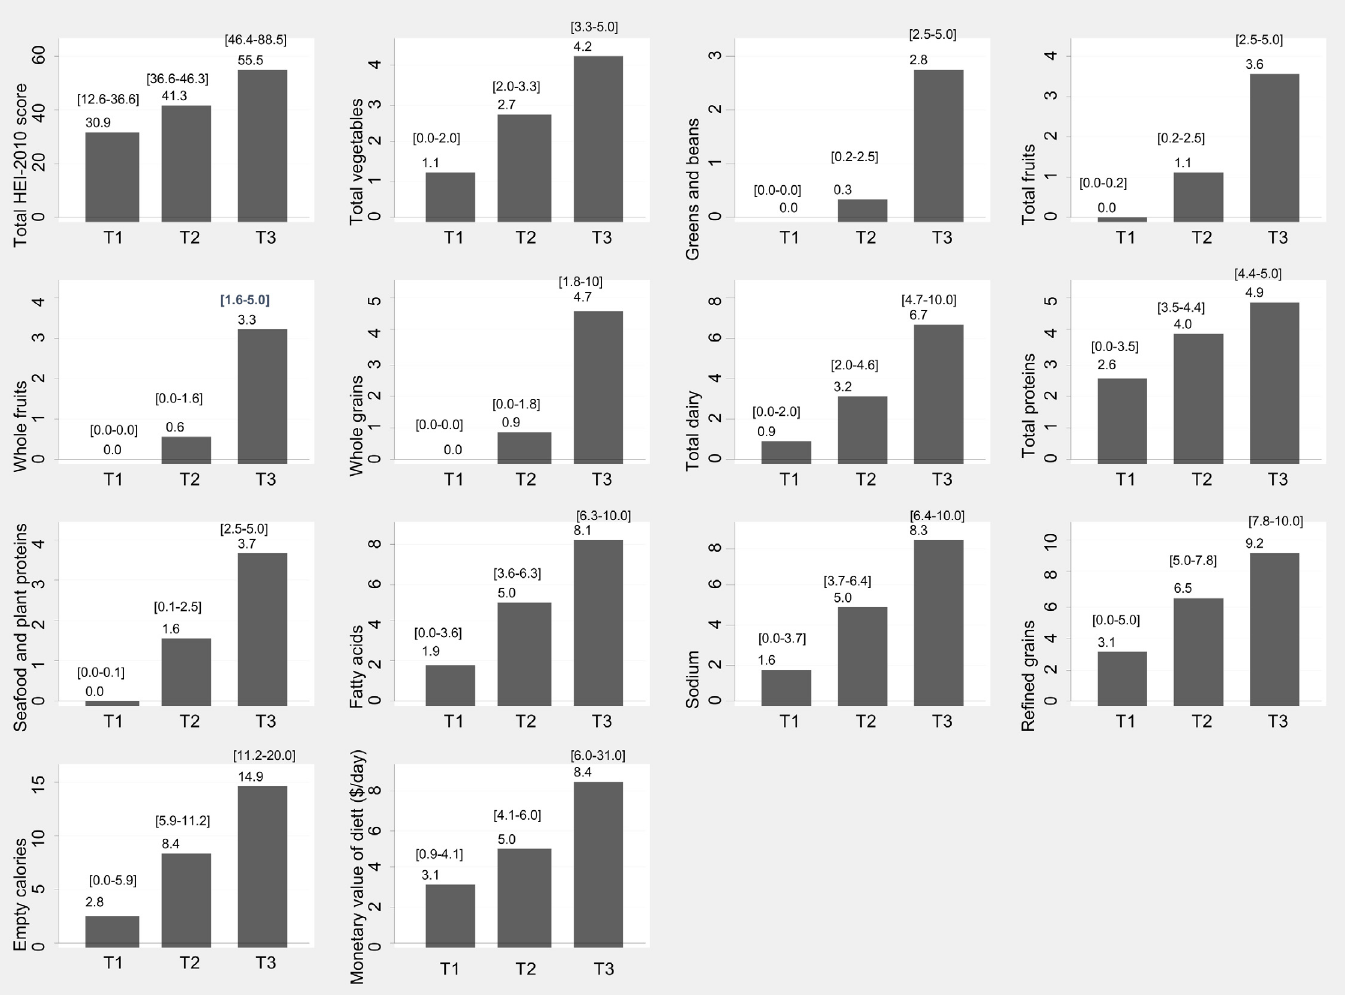
Fig 1. Means and [ranges] of HEI-2010 (total score and components) and of monetary value of diet (MVD, $/day) by their respective tertiles; HANDLS study, wave 1.